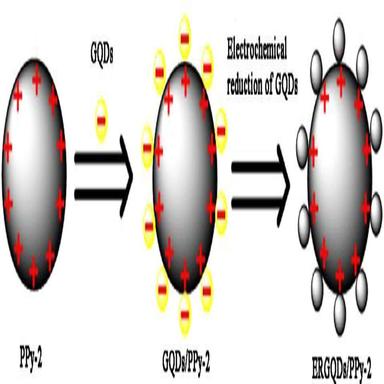
Schematic illustration showing the preparation of ERGQDs/PPy-2.